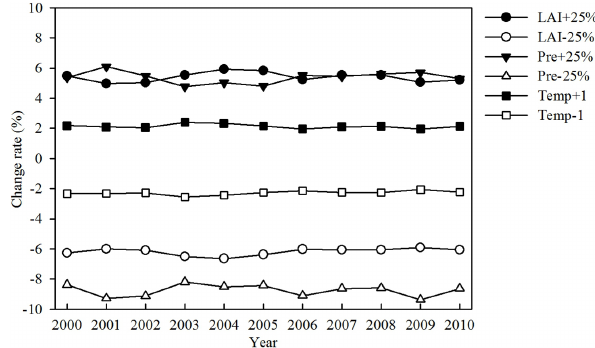
Fig. 16. Changes of simulated national total ET under different dis- turbance scenarios of precipitation, temperature, and LAI relative to the corresponding values simulated using undisturbed inputs during the 2000–2010